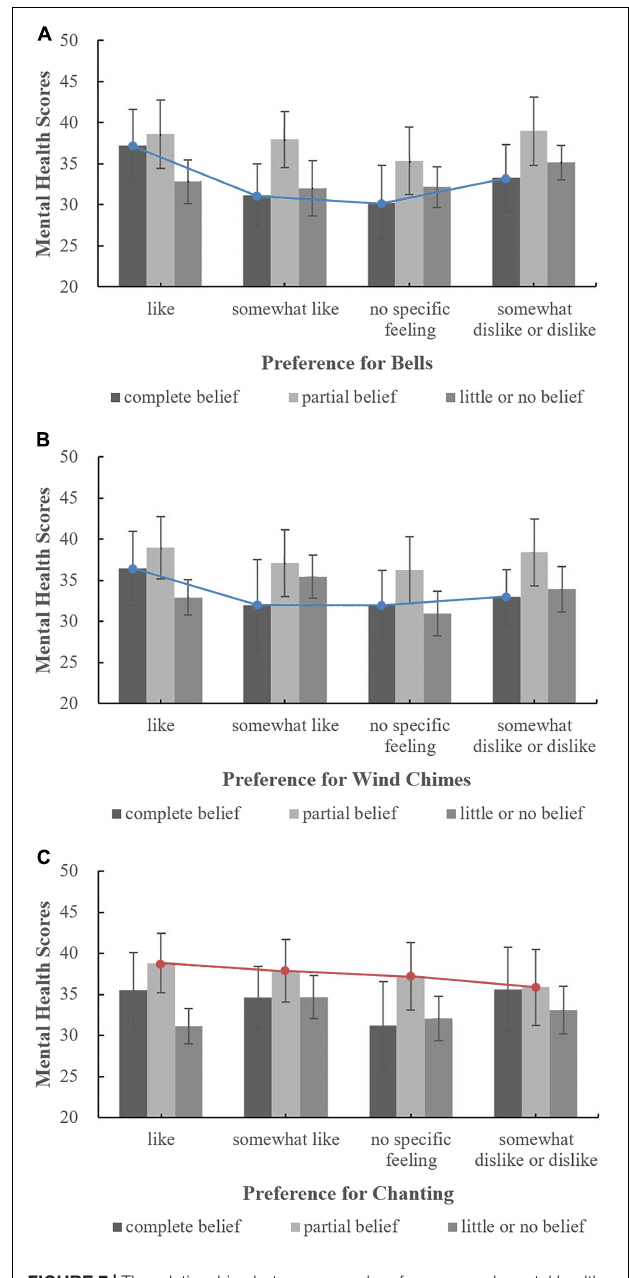
FIGURE 7 | The relationships between sound preferences and mental health by level of belief in Buddhist thought. (A) Bells; (B) Wind chimes; (C) Chanting.